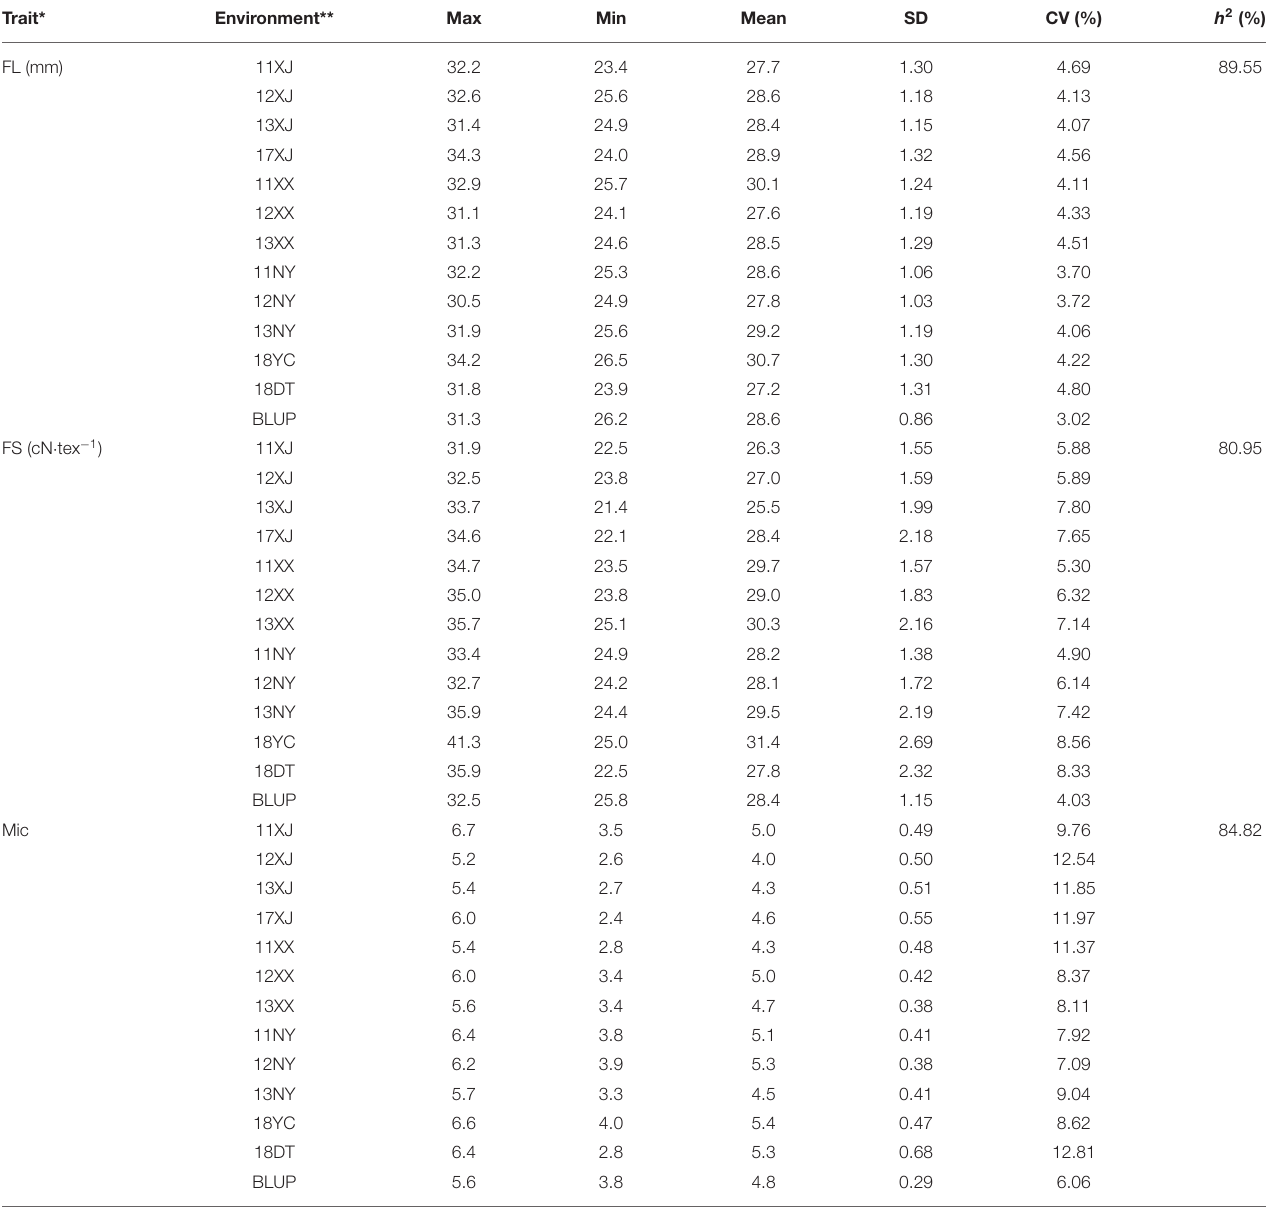
TABLE 1 | Phenotypic variation for three fiber quality traits in multiple field environments and their heritability. Trait*